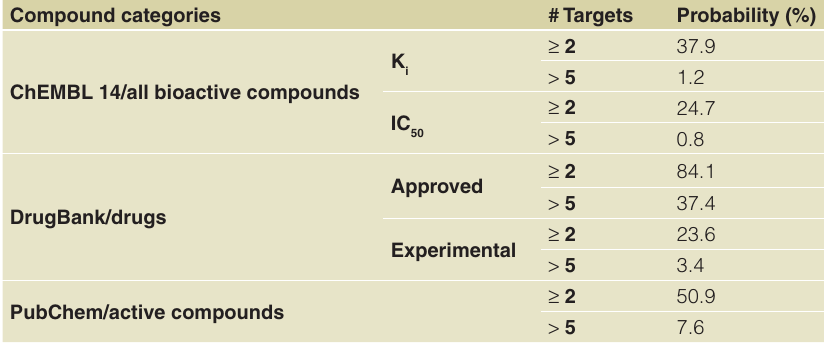
Table 2. Probability of promiscuity.